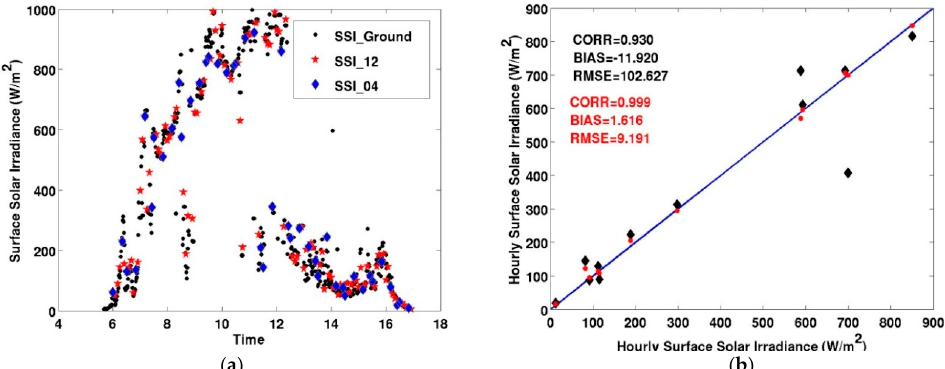
Figure 3. Data from 13 March 2018 at the Institute of Methodologies for Environmental Analysis of the National Research Council of Italy (IMAA/CNR). ( a ) Surface solar irradiance estimate by AMESIS based on 4- (SSI_04) and 12- (SSI_12) hourly samples against measurements by ground-based pyranometers (SSI_ground); ( b ) Scatter plot of the AMESIS hourly surface solar irradiance estimates based on 4- (black diamonds) and 12- (red circles) hourly samples against the irradiance measured with the pyranometer.